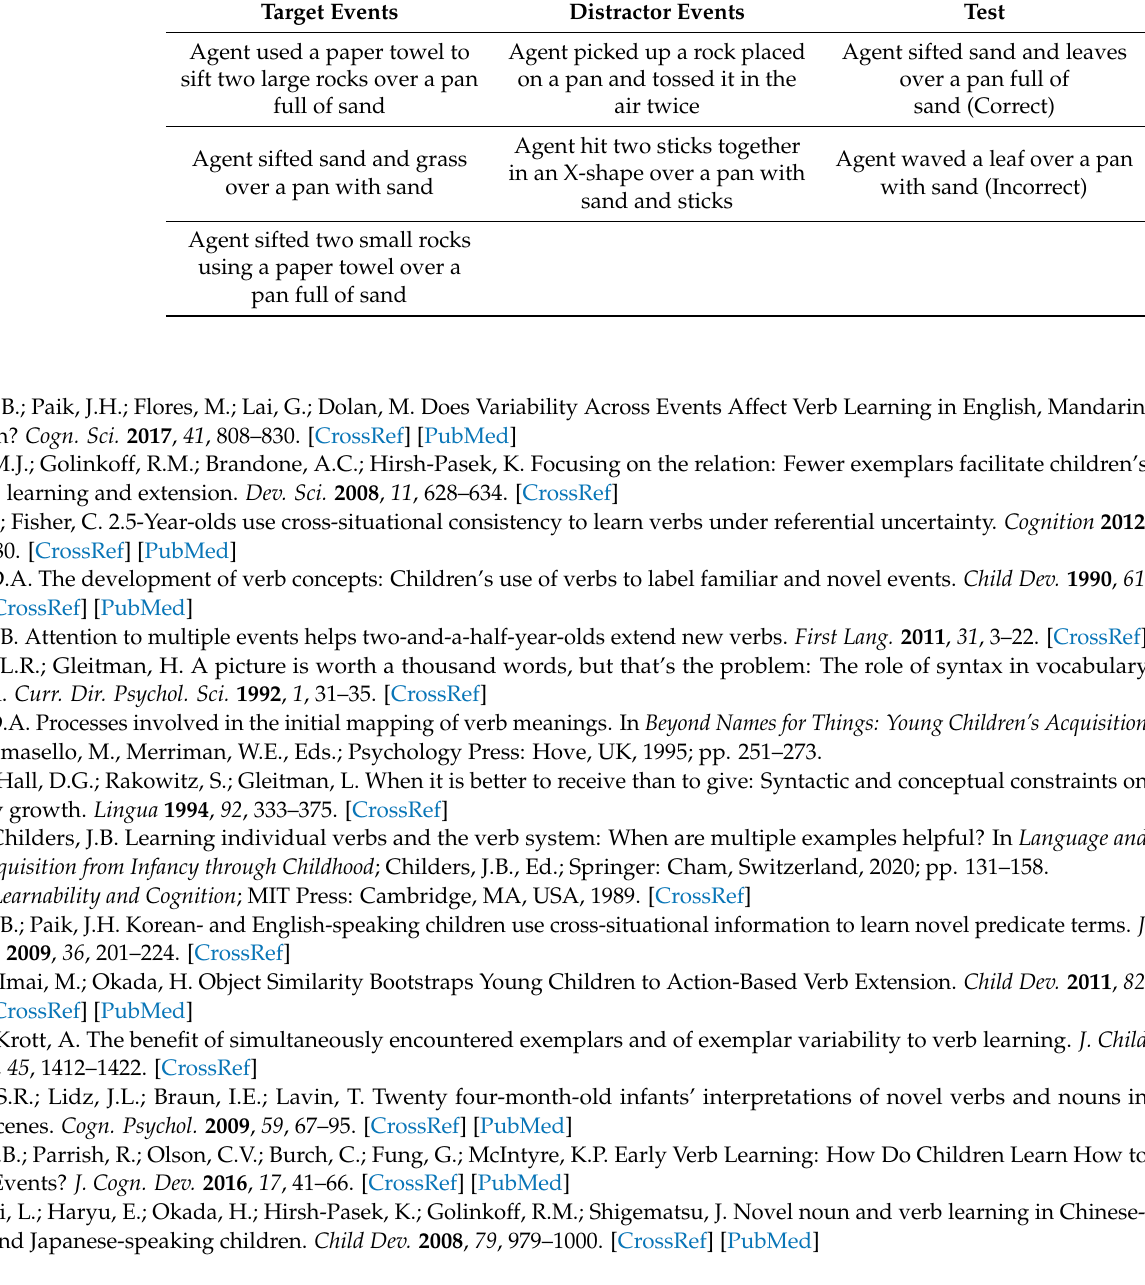
Table A2. Target Event: “Snarf”. Set 1 (Park 1: To Pick Up Something Using an Open Hand) Target Events Distractor Events Test Agent picked up a pebble A stick was pushed in a circle Agent picked up a rock using using the palm of their hand with one finger an open hand (Correct) Two rocks in the center of the table were picked up and Agent picked up a stick using A leaf was picked up and placed on two opposite sides the palm of their hand waved in the air of the table (Incorrect) Agent picked up a leaf using the palm of their hand Set 2 (Park 2: To Sift Objects Using a